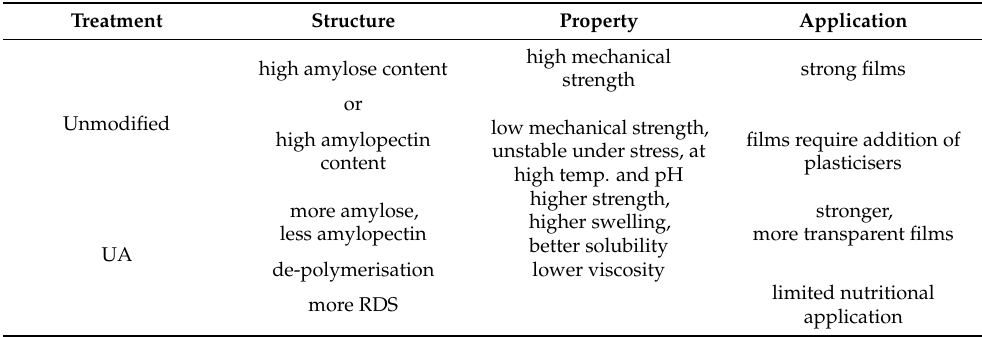
Table 1. The comparison of structure, properties and applications of unmodified and UA-treated starch. Treatment Structure Property Application